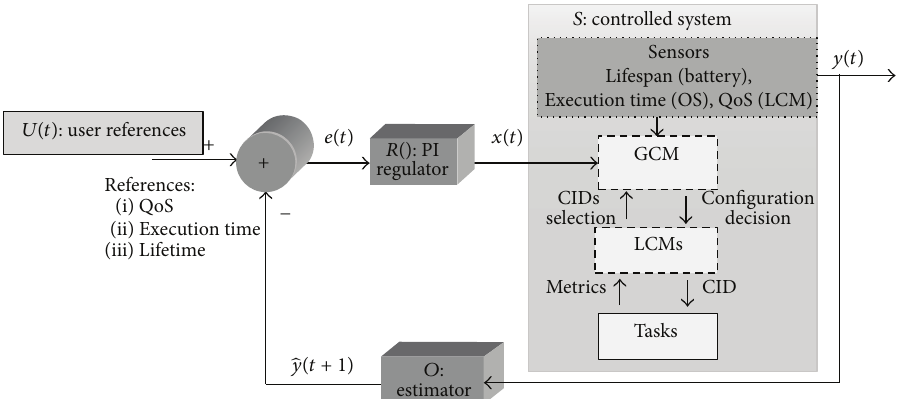
Figure 13: Global structure of the closed-loop self-adaptive system proposed in